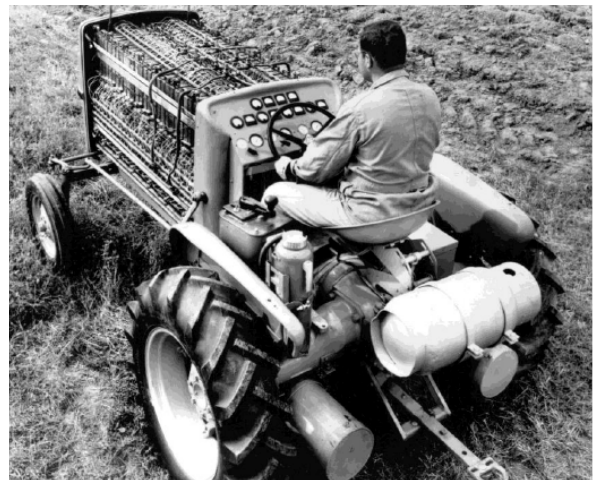
Figure 6. Allis-Chalmers fuel cell tractor, 1959. From the Science Service Historical Images Collection, courtesy Allis-Chalmers